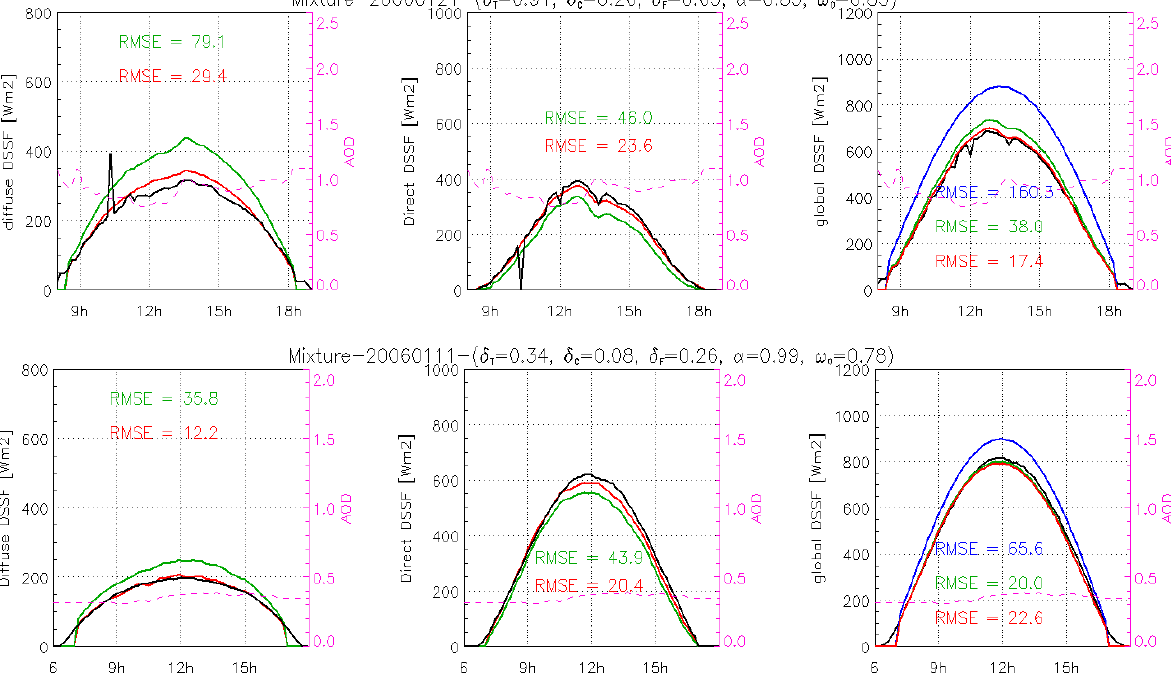
Figure 7. Same as Figure 5 for mixture days in Dakar (21 January) and Niamey (11